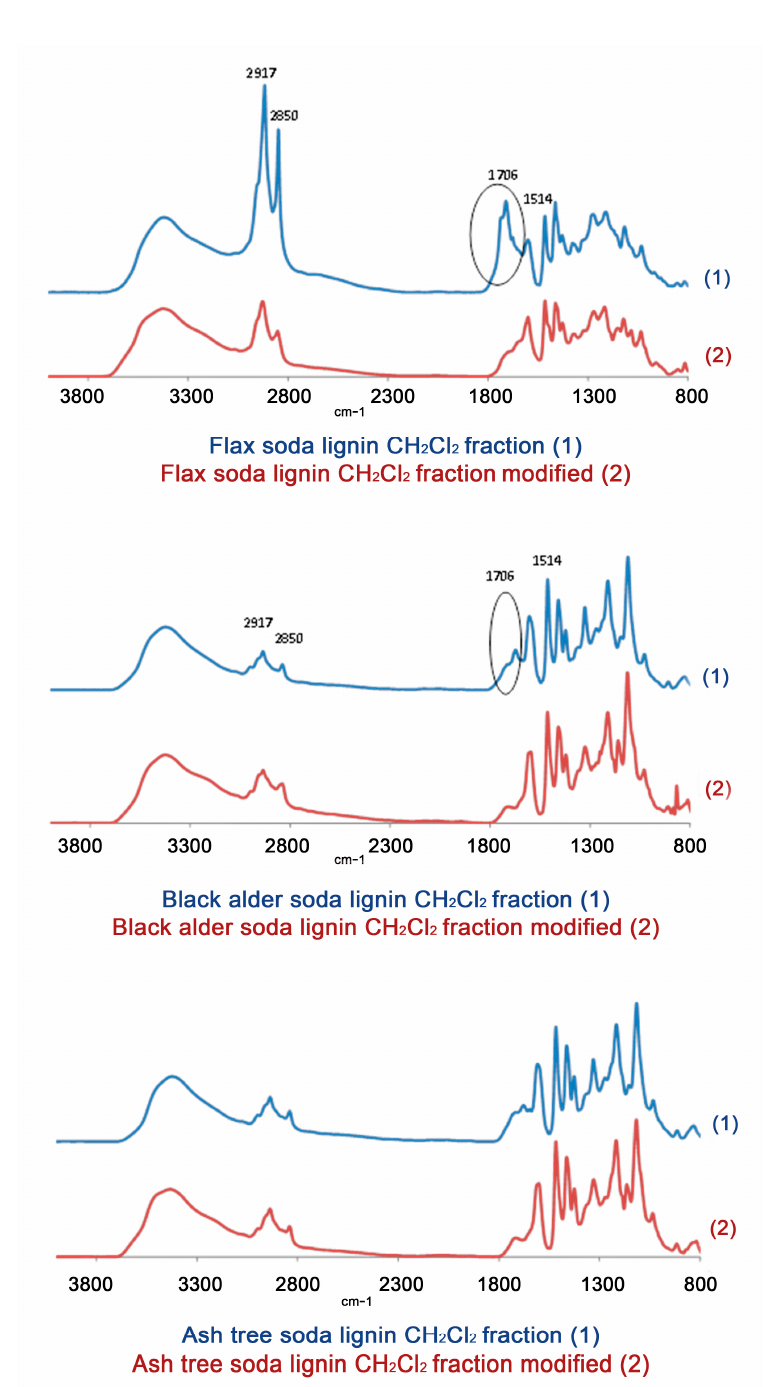
Figure 7. FTIR spectra of fractions obtained from soda lignins under study ( 1 ) before and ( 2 ) after their chemical modification (elimination of carbonyl groups).